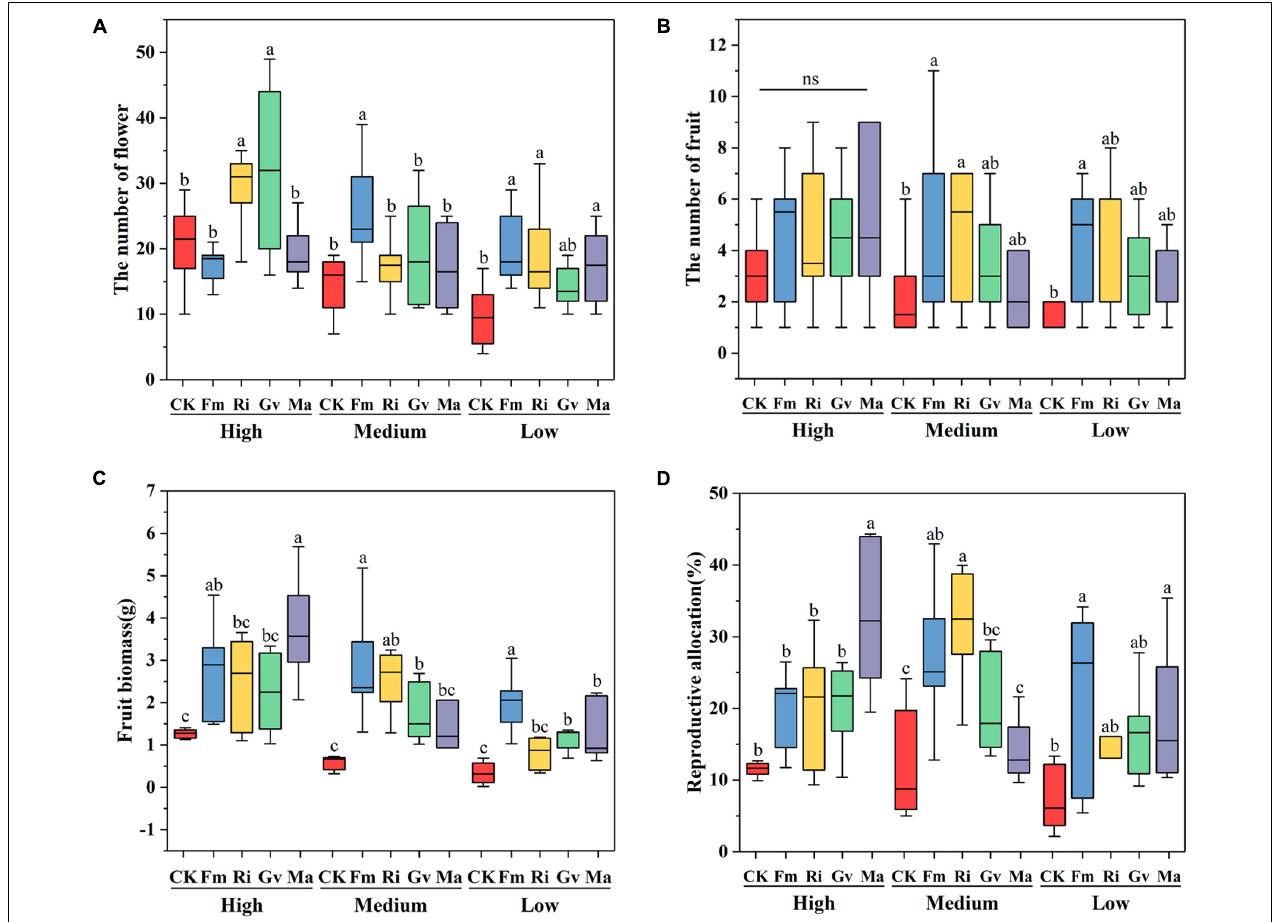
FIGURE 4 | Effects of AMF inoculation on flower number (A) , fruit number (B) , fruit biomass (C) , and reproductive allocation (D) of cherry tomato under different nutrient